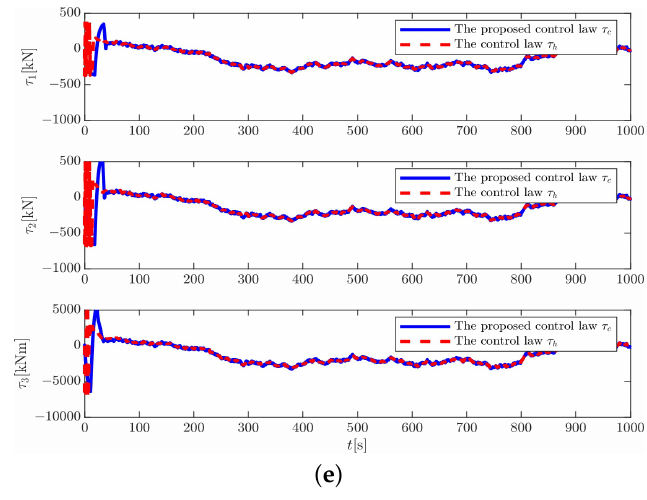
Figure 4. Simulation comparison between this paper and paper [46] for dynamic positioning output feedback control strategy: ( a ) ship horizontal motion trajectory; ( b ) ship position and heading; ( c ) comparison between the observed speed of FDESO proposed in this paper and the real speed; ( d ) comparison between the observed speed of high-gain observer proposed in [46] and the real speed; ( e ) comparison between the actual thrust generated by the ship thruster in this paper and in